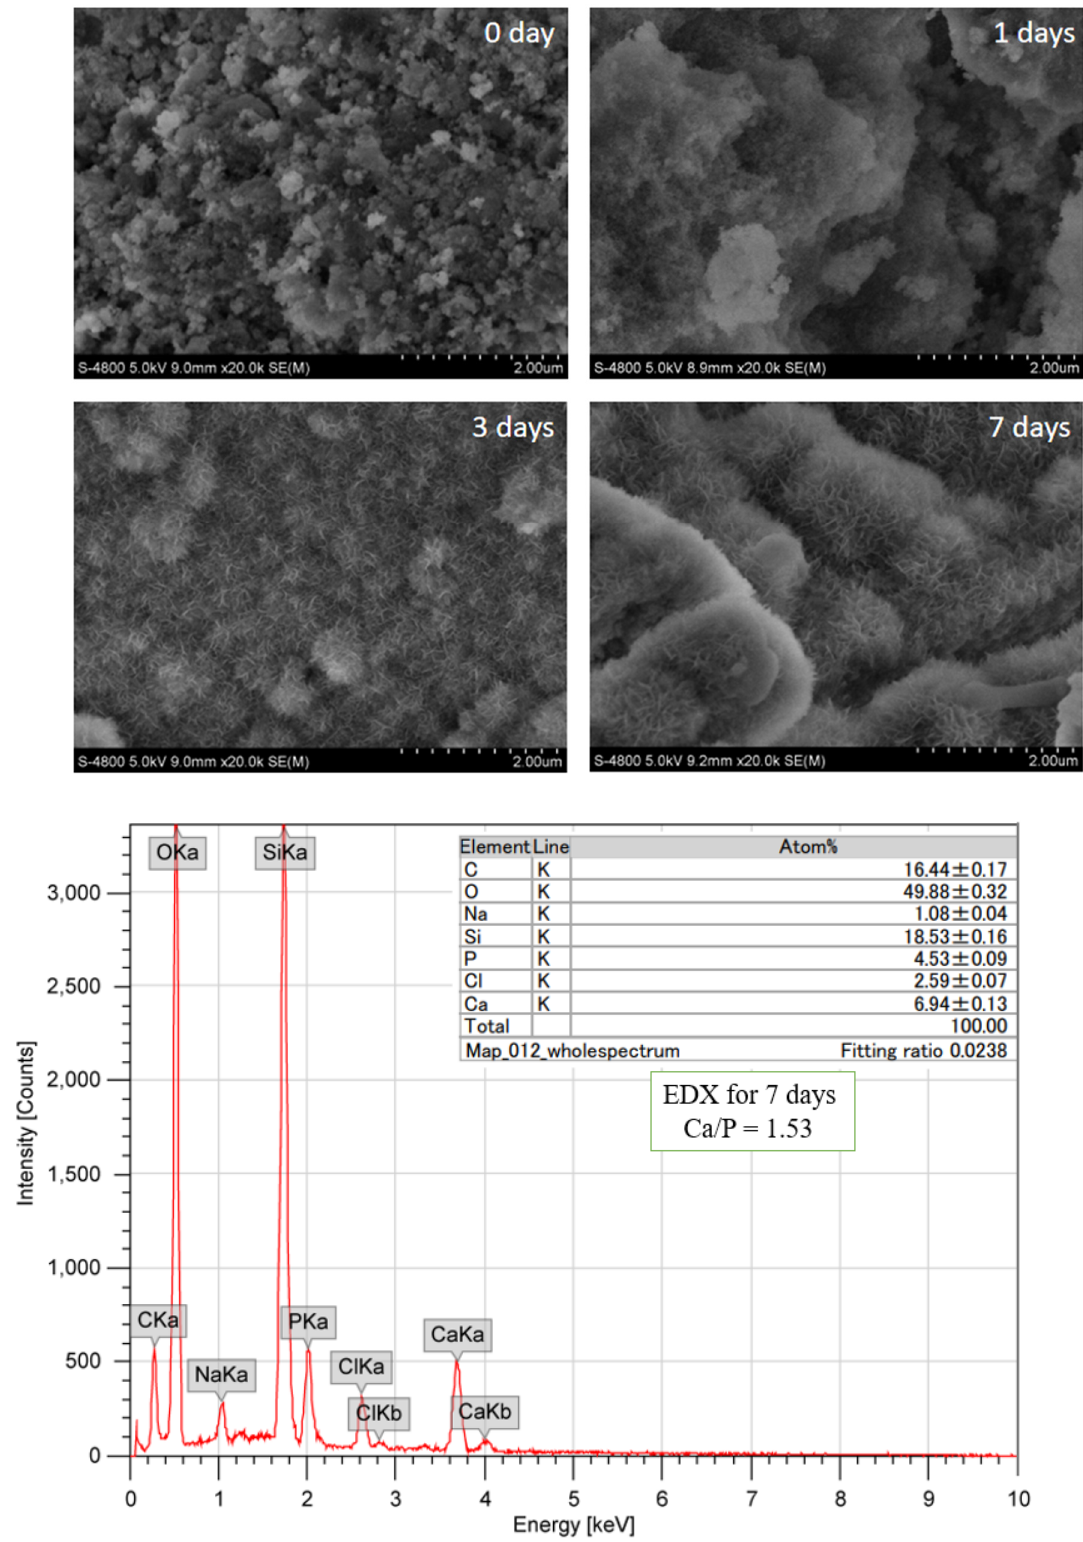
Figure 5. FE-SEM and EDX analyses of bioactive glass samples after immersion in simulated body fluid (SBF).